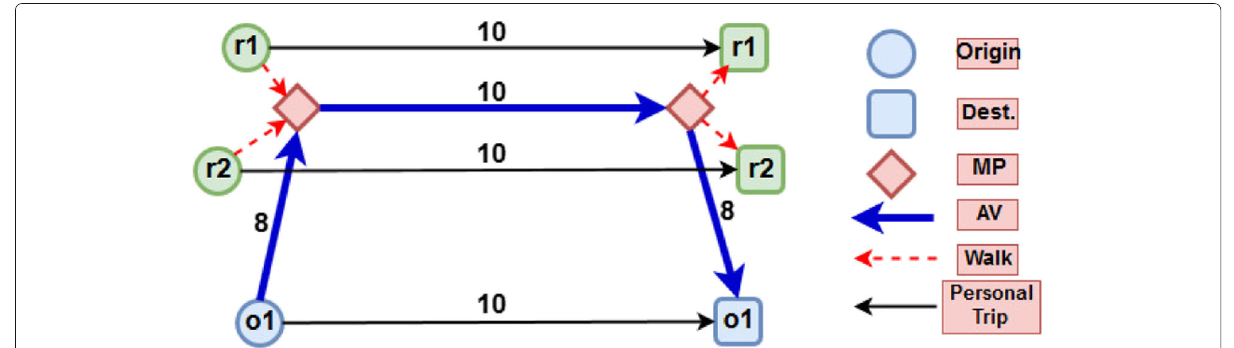
Fig. 2 Distance feasible match - Positive distance saving